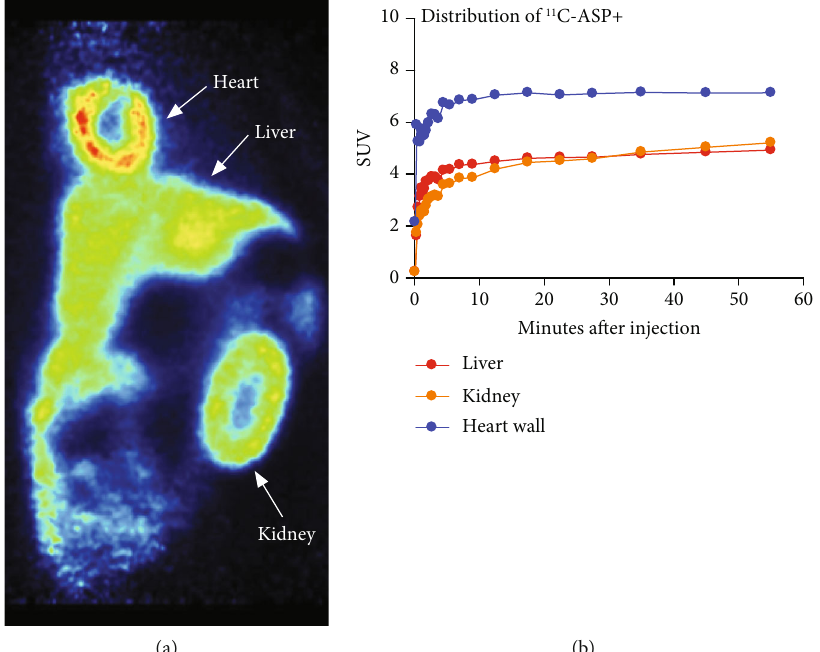
Figure 3: Whole body PET with 11 C-ASP+.(a) Coronal image of PET summed over 60 minutes. (b) Time-activity curves for the heart wall, liver, and kidney cortex show accumulation of 11 C-ASP+ in these organs. No decrease in 11 C-ASP+ signal was seen during the scanning